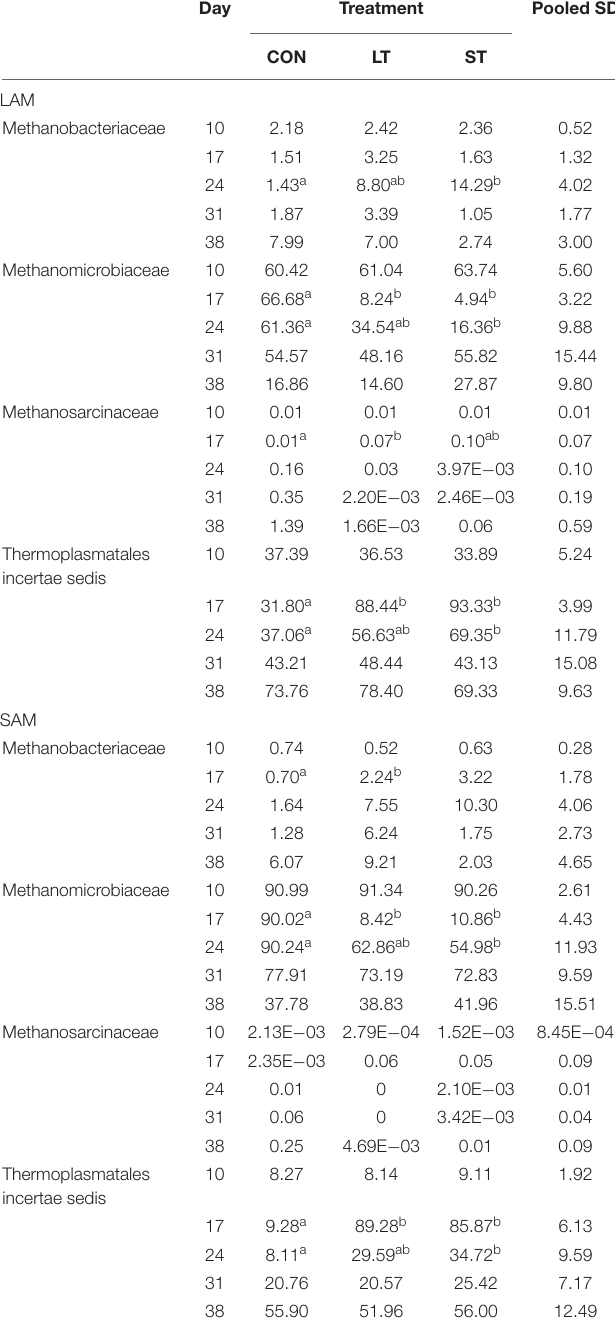
TABLE 4 | Differentially abundant archaeal families by treatment group in liquid- and solid-associated microbiota (LAM and SAM, respectively). Day Treatment Pooled SD CON LT